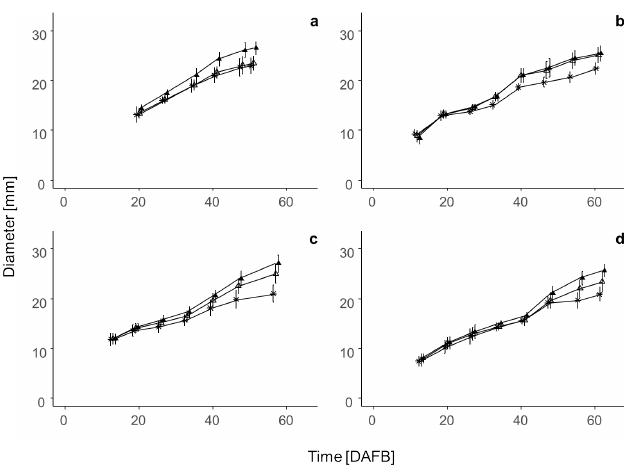
Fig. 7: Time course of changes in fruit diameter of sweet cherry cultivars 'Bellise' (a: 2018, c: 2019) and 'Regina' (b: 2018, d: 2019) develop- ing at different leaf:fruit ratio (star: 1:1, open triangle: 2:1, closed triangle: 4:1). Error bars show the standard deviation.